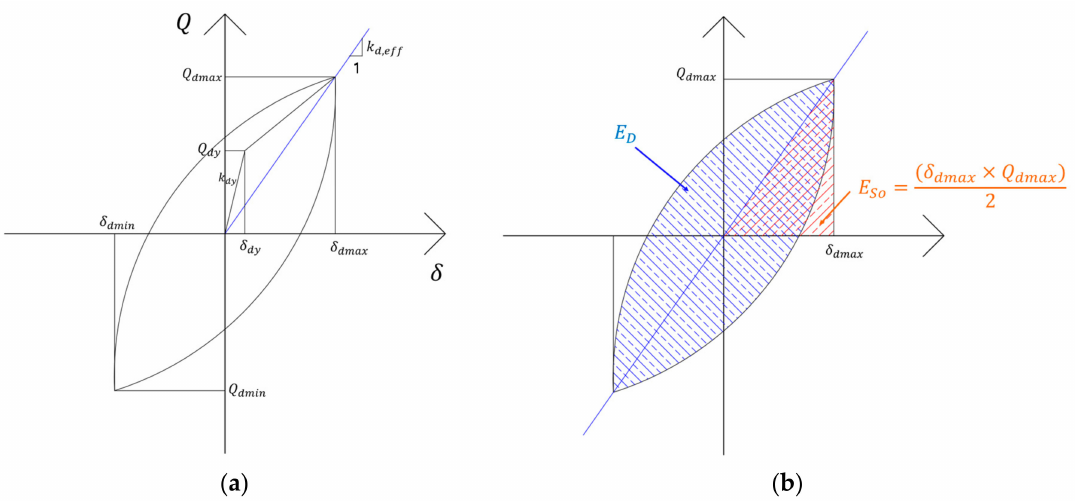
Figure 8. Concepts of effective stiffness, elastic potential energy, and energy dissipation in seismic control systems: ( a ) effective stiffness and ( b ) elastic potential energy and cumulative energy dissipation.